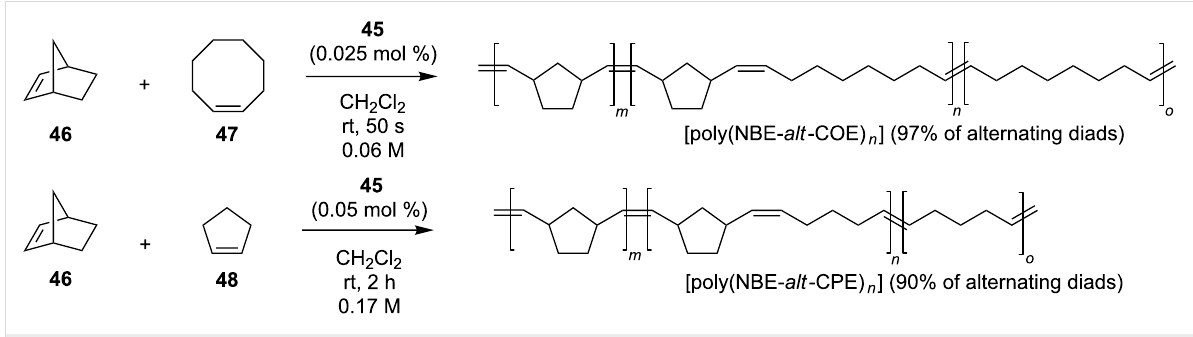
Scheme 6: Alternating copolymerization of 46 with 47 and 48 .